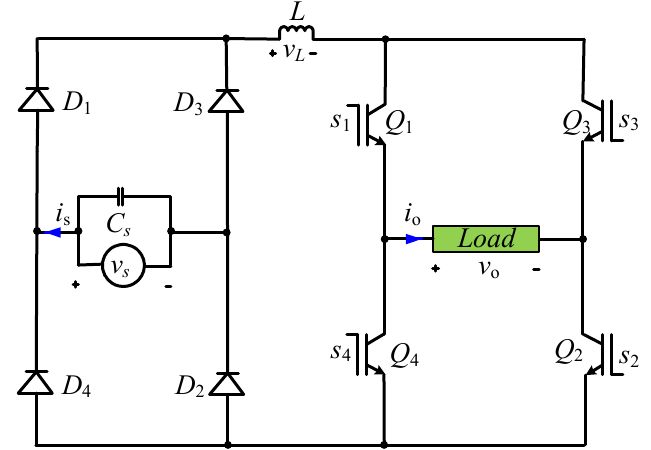
Figure 5. Circuit arrangement of the proposed